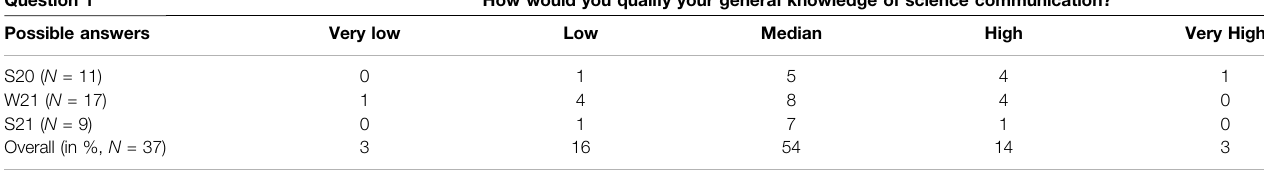
TABLE 1 | Results of the pre-course survey over three teaching sessions. Question